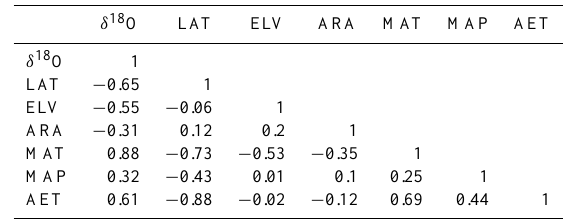
Table 3. Correlation matrix among δ 18 O and parameters LAT, ELV, ARA, MAT, MAP, and AET meaning latitude, elevation, catchment area, mean annual precipitation, mean annual temperature, and ac- tual evapotranspiration,